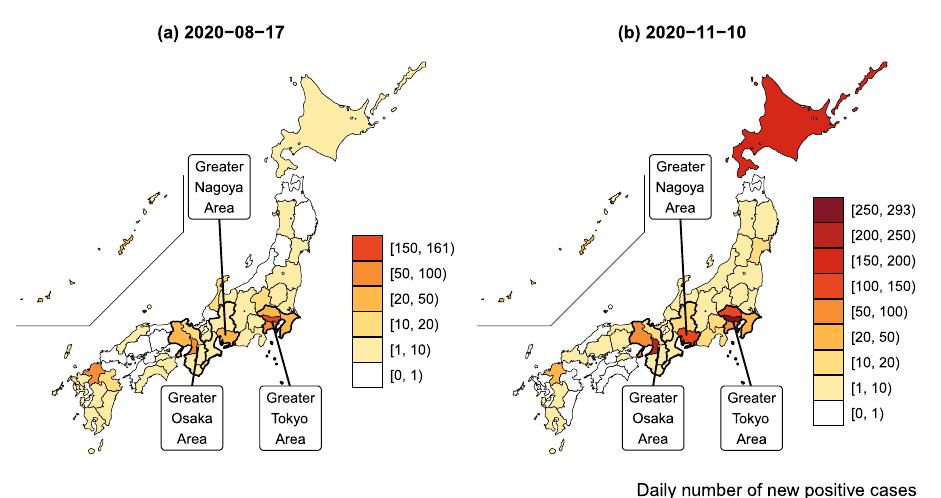
Figure 2. COVID-19 infections across prefectures. This map was constructed by the author from data of the daily number of positive tests. The original data on COVID-19 cases was compiled from the NHK 50